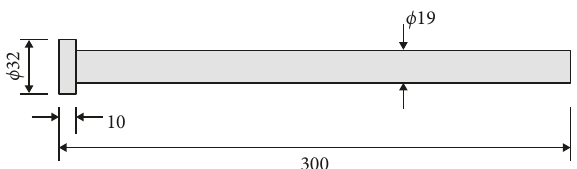
Figure 4: Details of the headed stud shear connector.